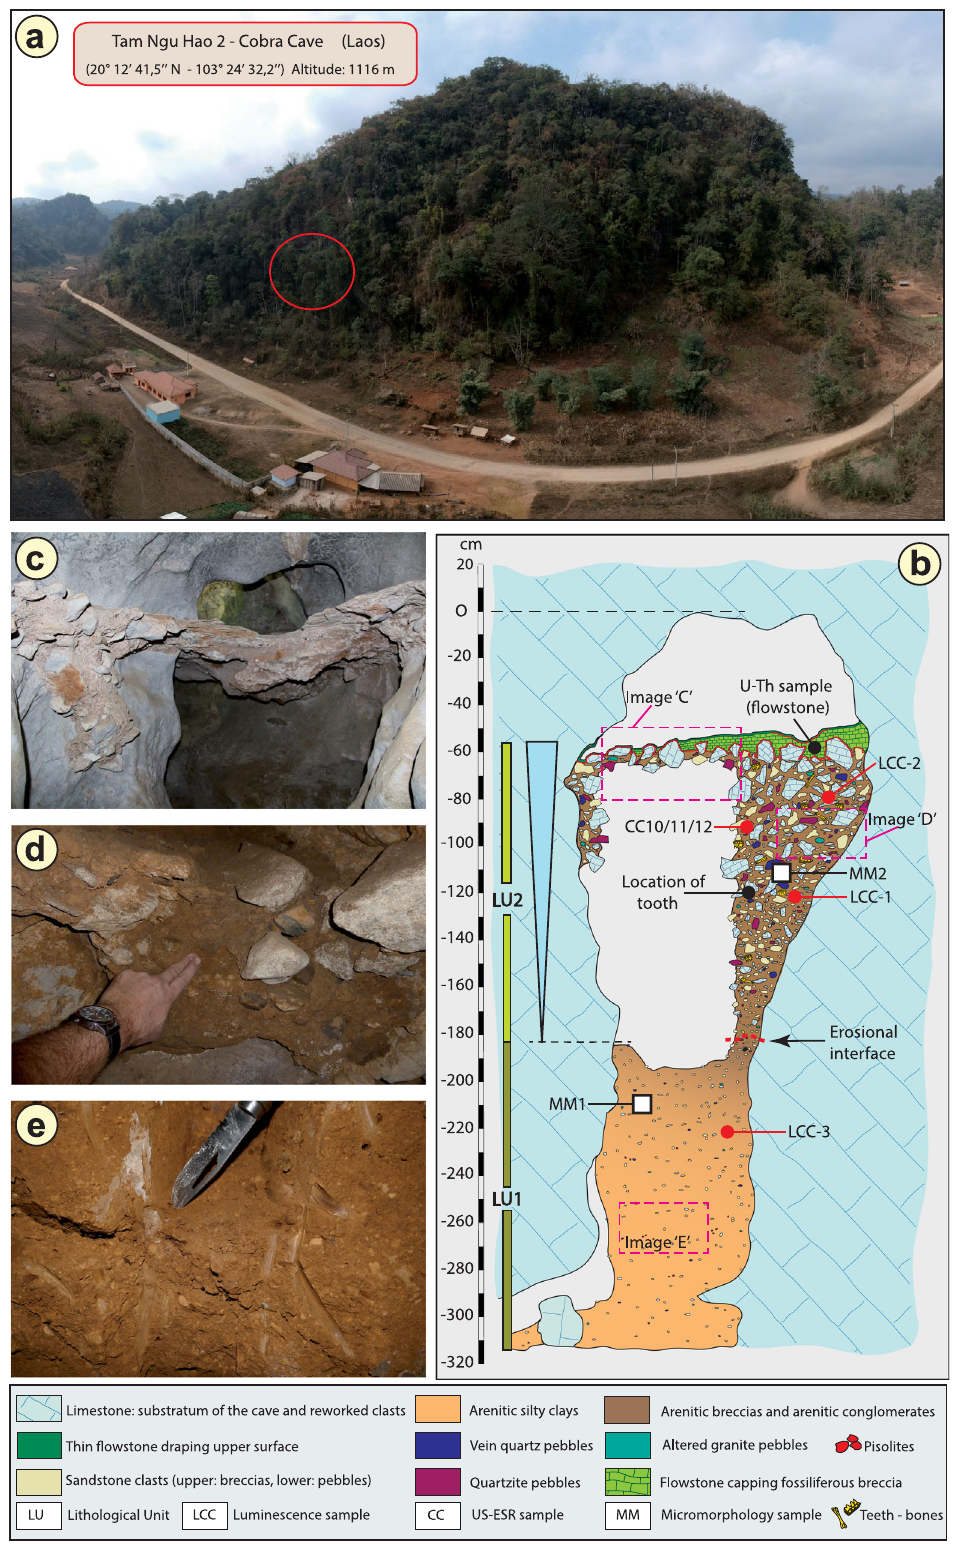
Fig. 1 Geomorphological context and stratigraphy of TNH2. a Aerial view of the site. The red circle indicates the entrance of Tam Ngu Hao 2 cave. b Stratigraphy and sampling locations of the in fi lling of the cave, showing Lithological Unit 1 and 2 (LU1 and LU2) with the erosional interface between these layers indicated by a dashed red line; Micromorphological (microstratigraphic) samples (MM1 and MM2) are also shown. Encircled numbers denote approximate positions of photographs in c , d and e . c View of the fl owstone capping the upper remaining part of LU2. d Detail of the arenitic breccia/ conglomerate of LU2. e Detail of the arenitic silty clay of